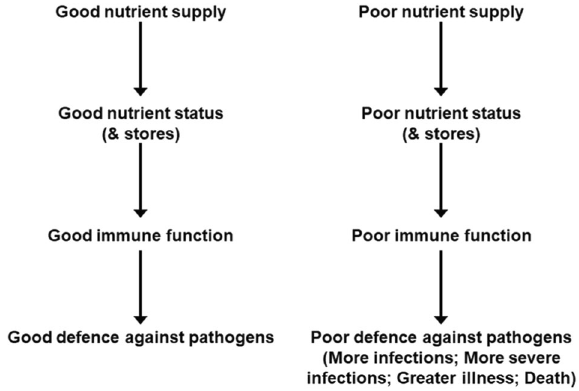
Fig. 4 Relationships between good and poor nutrition, immunity and